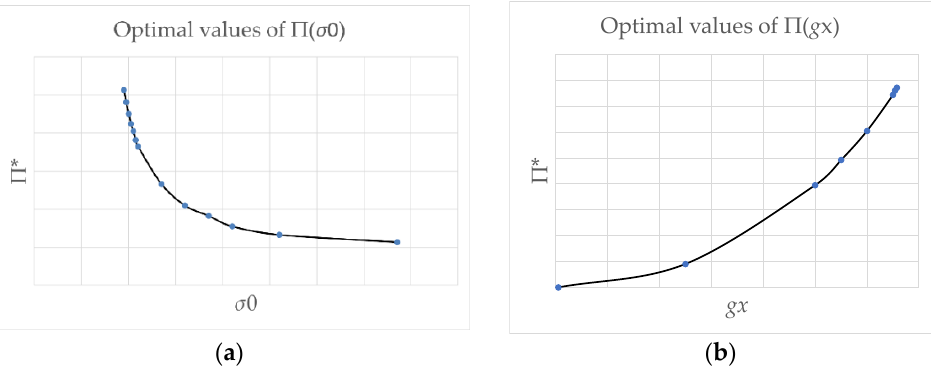
Figure 13. Optimal П * = П * (σ 0 , g x ) calculated for the rectangular cantilever (see Figure 5a) as a func- Figure 13. Optimal Π * = Π * ( σ 0 , g x ) calculated for the rectangular cantilever (see Figure 5a) as a function of: ( a ) yield stress tion of: ( a ) yield stress σ 0 , i.e., П * = П * (σ 0 ) (lateral load g x is fixed), ( b ) intensity g x of the traction Π * = Π * ( σ σ 0 , i.e., 0 ) (lateral load g x is fixed), ( b ) intensity g x of the traction load, i.e., load, i.e., П * = П * (g x ) (yield stress σ 0 is fixed).